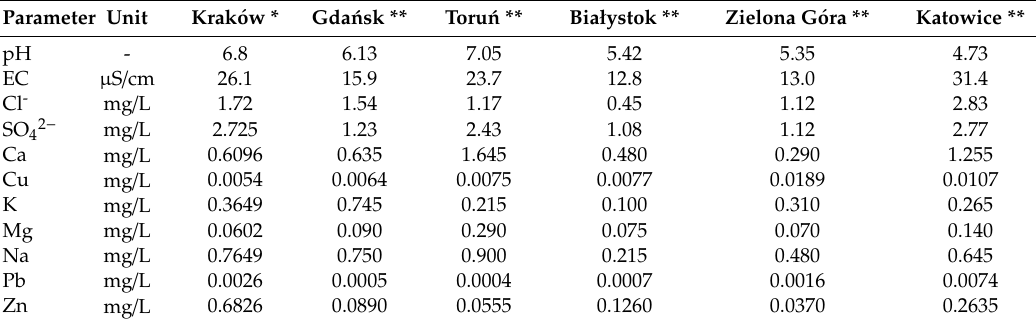
Table 2. Contents of the selected elements identified in the rainwater in Polish cities.